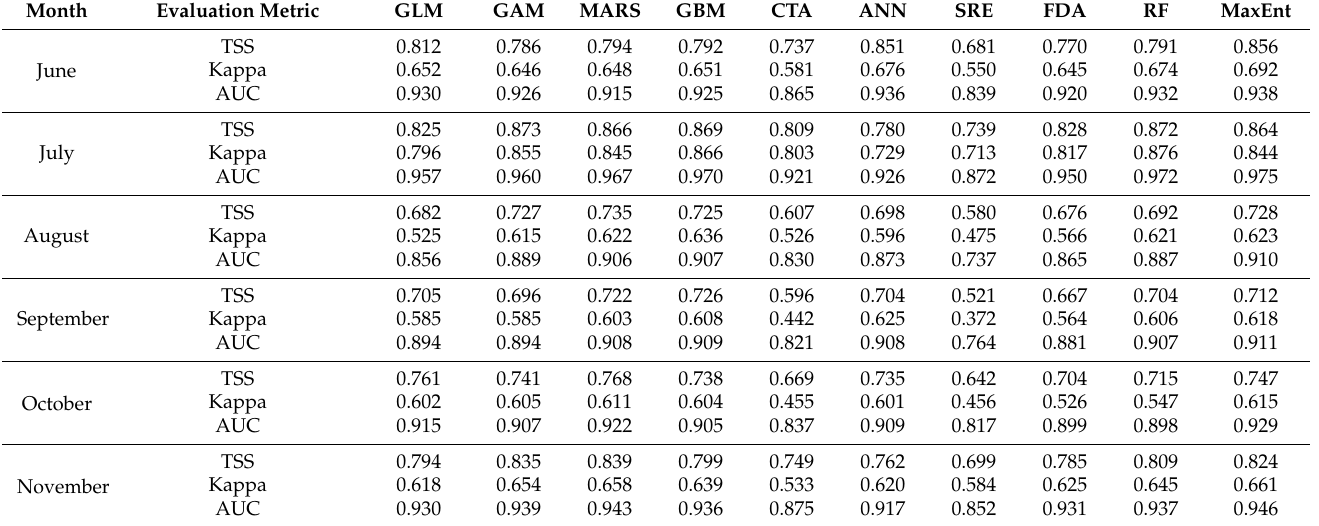
Table 4. Evaluation metrics for single-algorithm models.